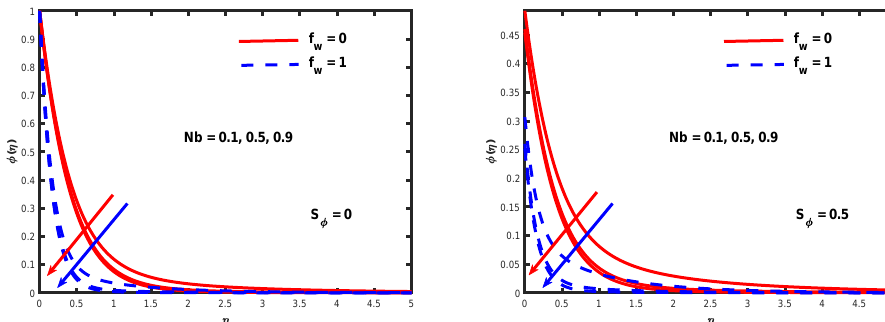
Figure 14. Influence of suction/injection and Brownian motion parameter on φ .